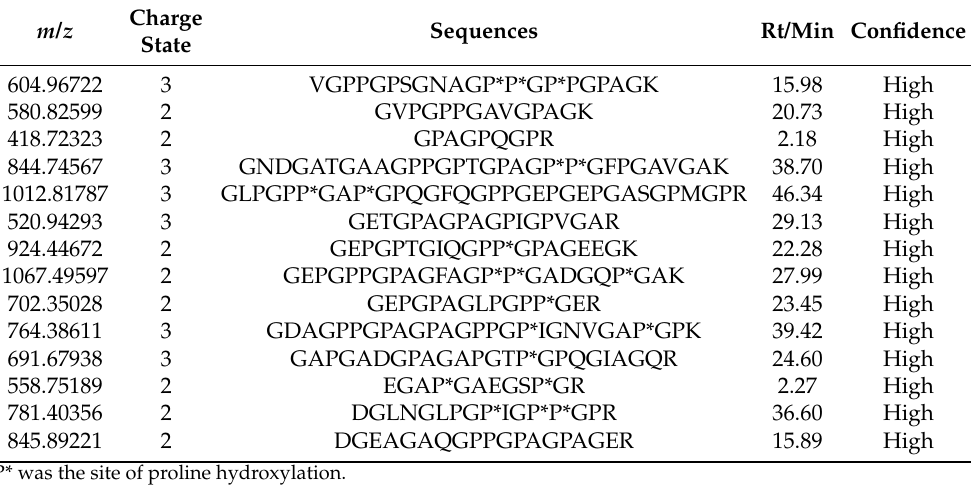
Table 1. The identified specific peptides of bovine type I collagen.